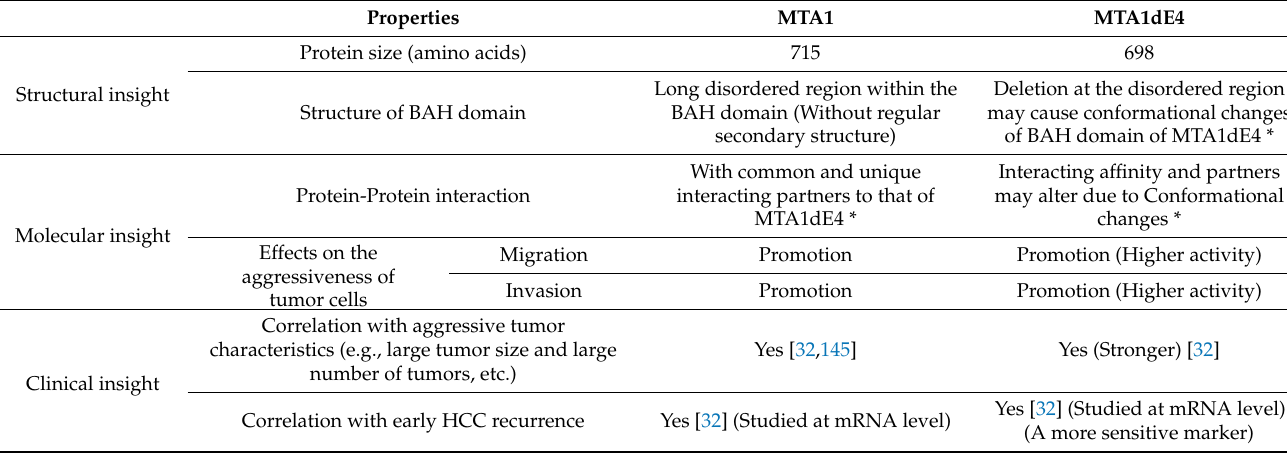
Table 2. Structural, molecular, and clinical insights into MTA1 and